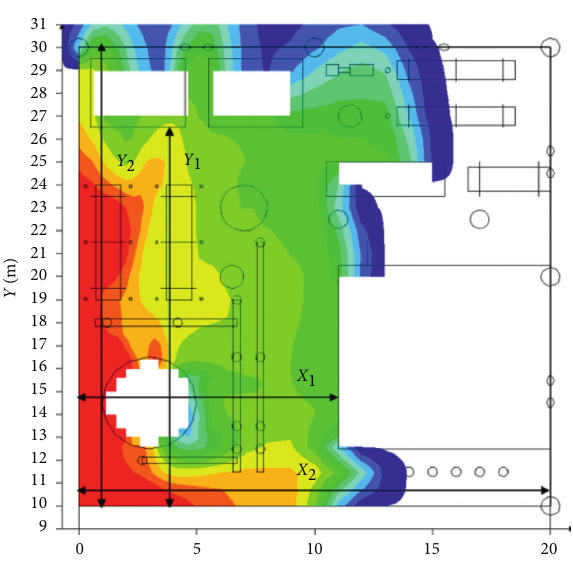
Figure 25: Schematic of X